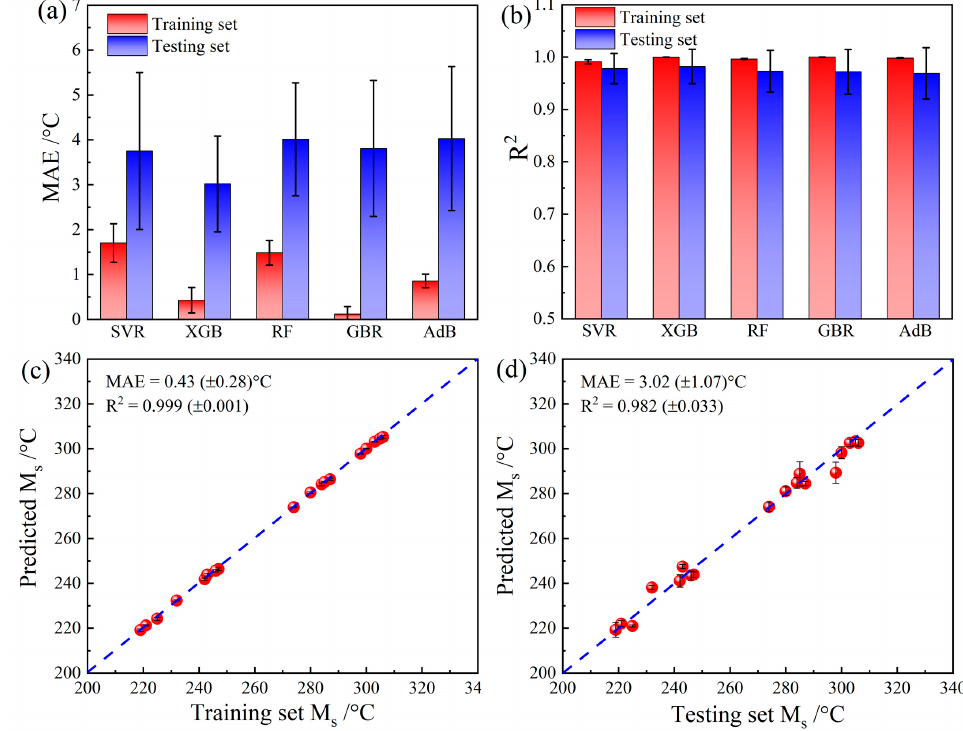
Figure 7. Comparison with traditional AI methods using only composition input: ( a ) comparison of MAEs, ( b ) comparison of R 2 values, ( c ) results of the training set for XGboost, and ( d ) results of the testing set for XGboost.